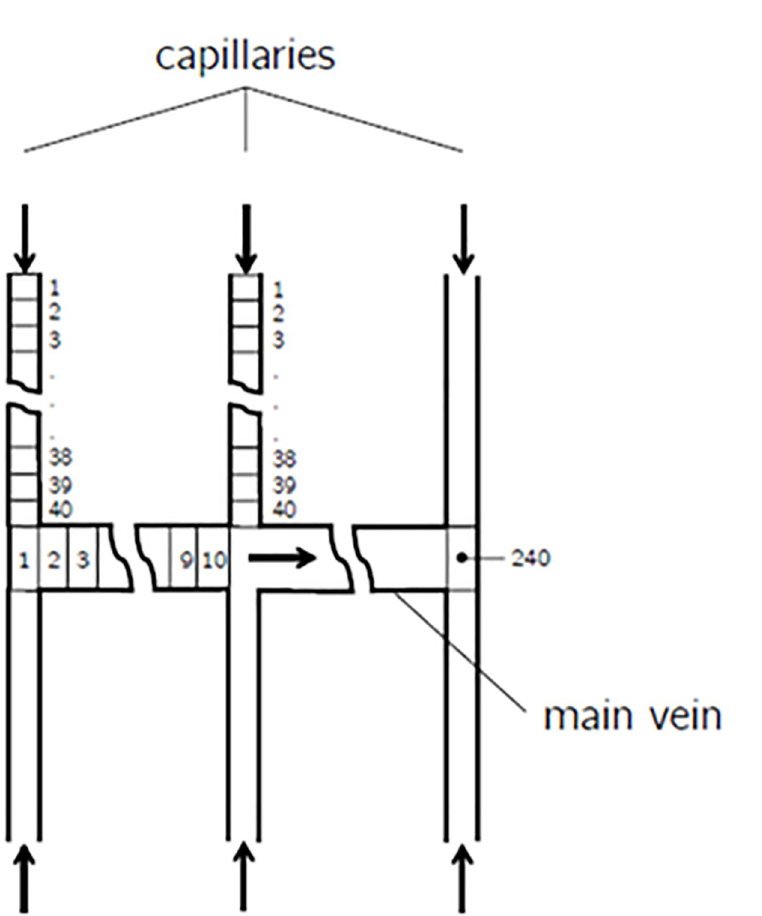
Fig 11. Segmentation of capillaries and main vein for the vein